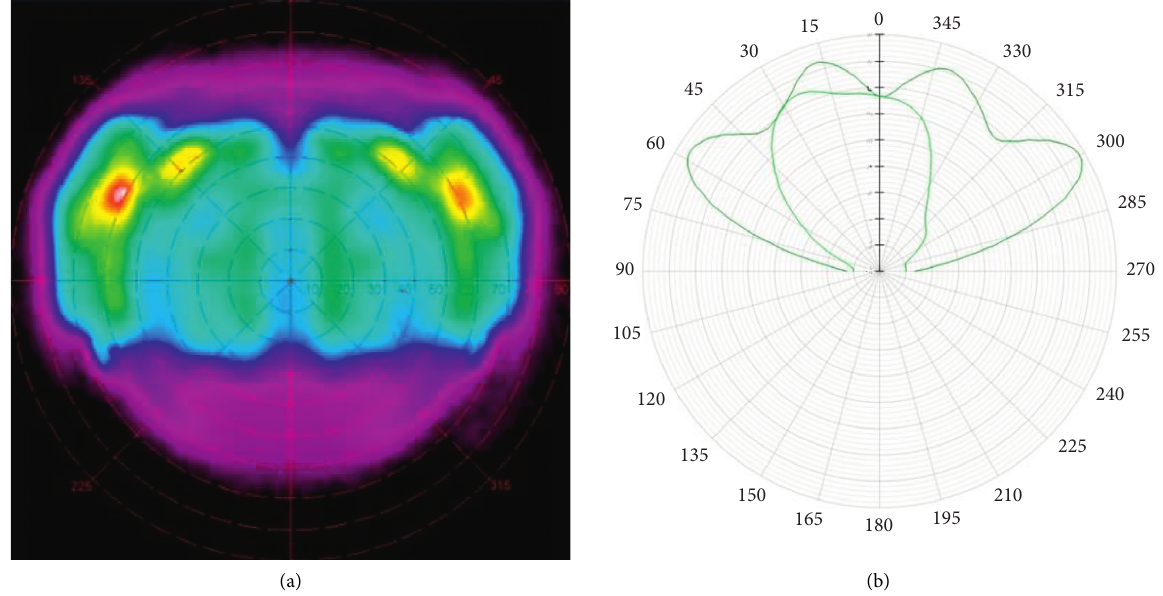
Figure 13: (a) The measured three-dimensional light intensity distribution map of the proposed street light prototype. (b) The measured LIDC of the proposed street light prototype. Table 3: DIALux simulation results using the imported measured IES file for the prototype street light obtained by imaging goniophotometer. U o U L TI For the whole road